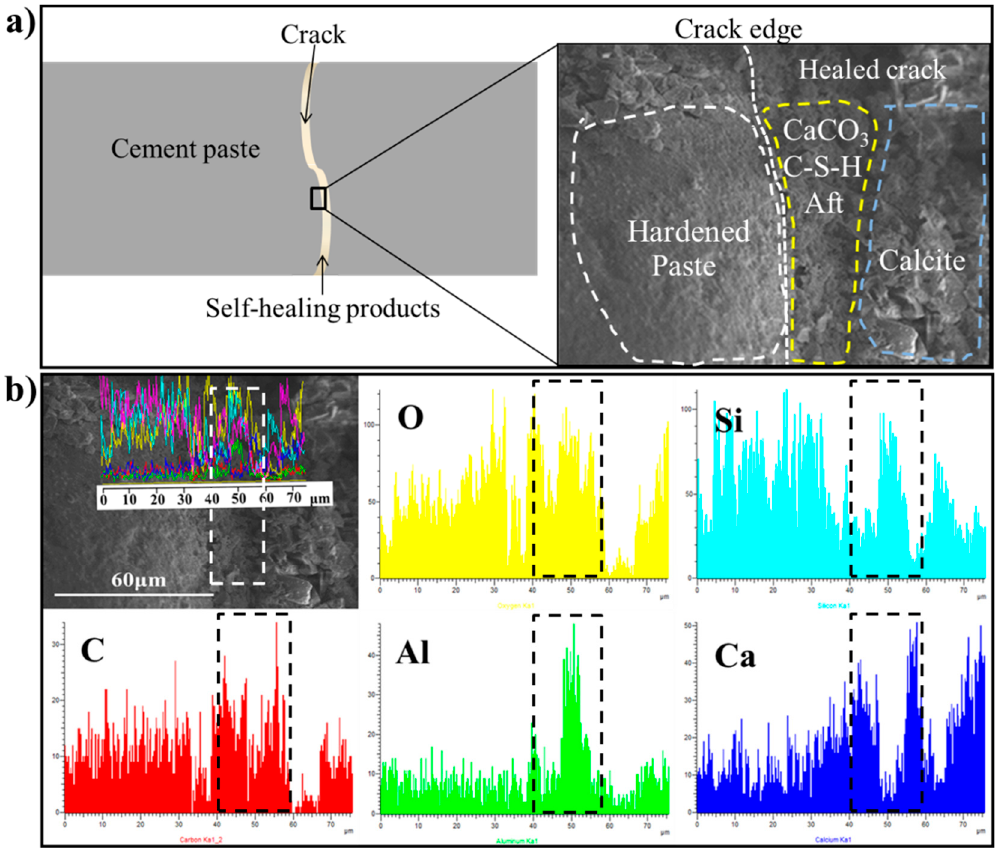
Figure 16. SEM-EDS analysis of cross-section after self-healing for 30 days. ( a ) is the target area of SEM-EDS; ( b ) is the linear scan and element distributions for the target area.